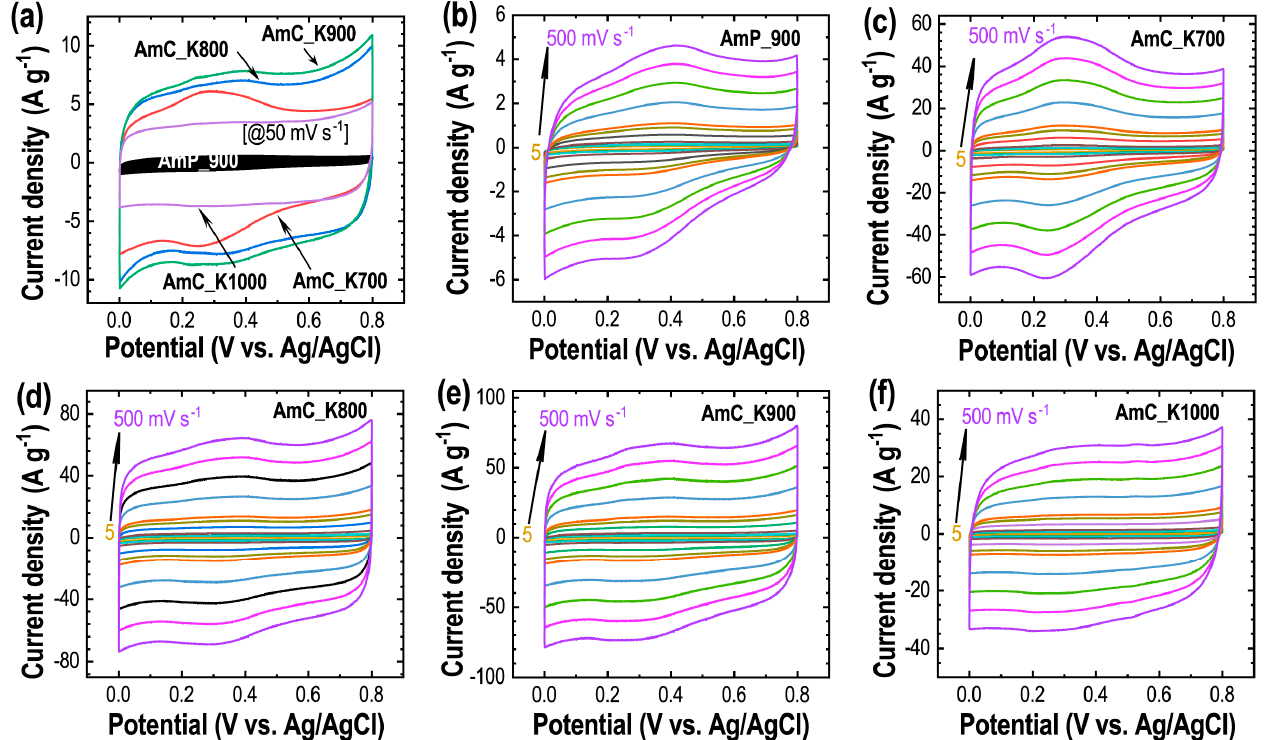
Figure 6. Electrochemical-energy-storage performance by CV measurements: ( a ) CV curves at fixed potential sweep of 50 mV s − 1 ; and CV curves recorded at various sweep-rates (5, 10, 20, 50, 80, 100, 200, 300, 400, and 500 mV s − 1 ) for ( b ) AmP_900; ( c ) AmC_K700; ( d ) AmC_K800; ( e ) AmC_K900; ( f ) AmC_K1000.